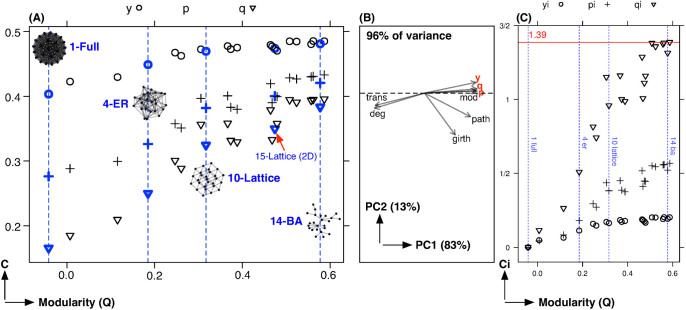
Cooperation Emergence Results Summary.Panel (A) shows the cooperation trend versus modularity for all structures with representative samples shown as dashed vertical lines with each respective structure embedded; the corresponding points for each sample line are shown in blue. The two-dimension square lattice data result is indicated by a red arrow in the figure. Panel (B) is a biplot44 where vectors (angles shown in table 1) represent the relative correlation of each continuous variant with the first two, most significant, principal components; proportion of variance for each component, is noted on panel (B). A dashed horizontal line on panel (B) is a guide to the eye for comparing the modularity biplot vector with the most significant component (PC1). Panel (C) shows the improvement in each cooperative component (Ci) over the 1-Full graph as modularity increases, where 1 represents a 100% improvement and 0 is the baseline for comparison (the fully connected graph). The red horizontal line is a guide for the eye representing the highest improvement, or 139% for component p.